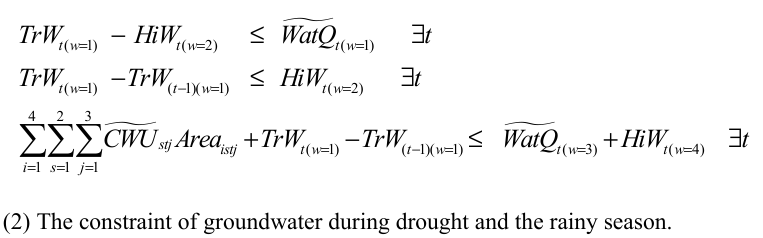
LQ Water Requirement ij (Cubic Meters /Rai)  ( ) ij CWU